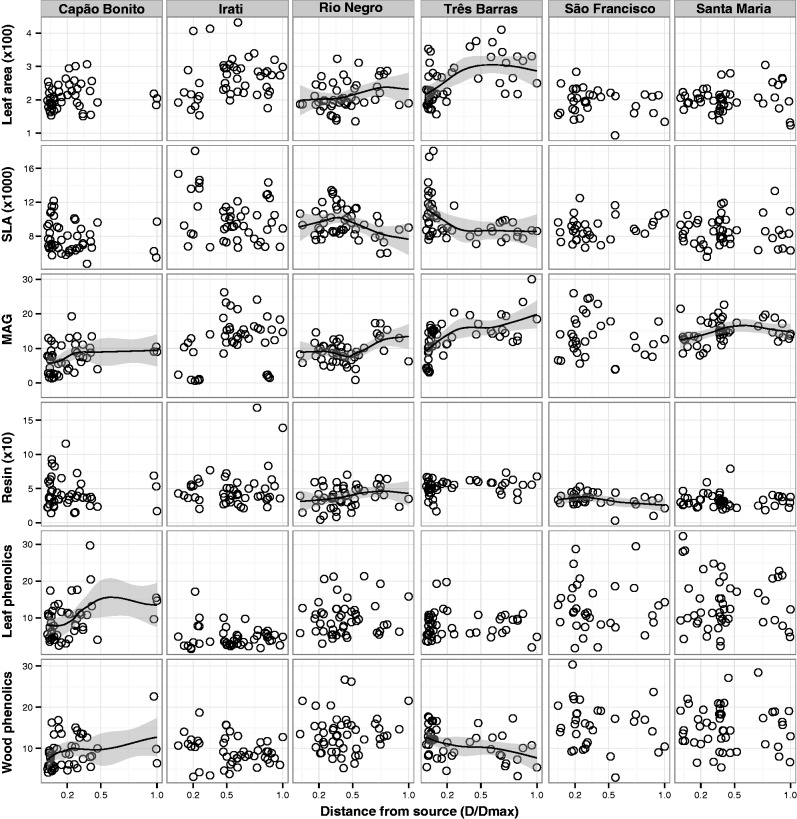
Relationship between productivity, growth, and defence traits and dispersal distance (D/Dmax, see Methods section for details). Scatterplots of leaf area (mm2), specific leaf area (SLA, mm2/g), mean annual growth (MAG, mm/year), non-volatile wood resin content (mg/g) and total needle phenolic content (mg/g) across the invasion gradient (normalized spread distance) for each invasive population. Lines represent local polynomial regression fit and grey shades are the 95% confidence intervals.